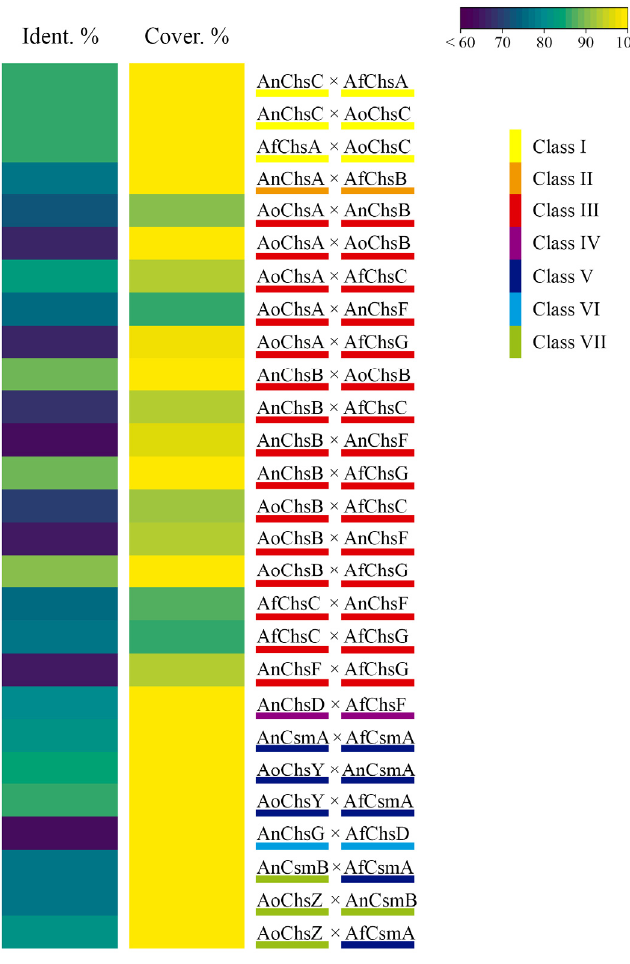
Figure 2. Chitin synthases (CS) of different classes are highly conserved amongst Aspergillus species. A heat map depicting the percentage (%) of identity and coverage between protein sequences of CS from the same classes of different Aspergillus species. The protein sequences were retrieved from the FungiDB database before pairs were submitted to BlastP for alignment analysis (BLAST Tool NCBI). An, Aspergillus nidulans ; Af, Aspergillus fumigatus ; Ao, Aspergillus oryzae . On the right, different coloured bars underlining the Aspergillus CSs are compared with each other, indicating the class of CS. On the left, heat maps depicting the percentage of identity and coverage between two CS protein sequences from different Aspergillus species.